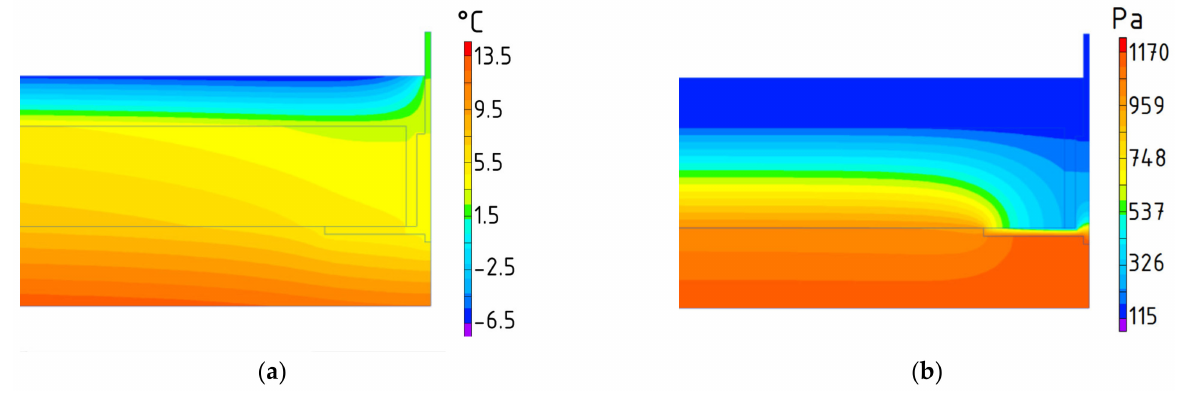
Figure 9. Fields: ( a ) temperature; ( b ) partial pressure of water vapor.